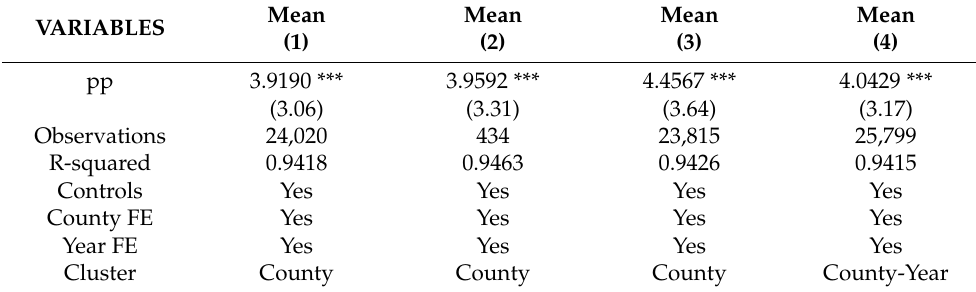
Table 4. Robustness